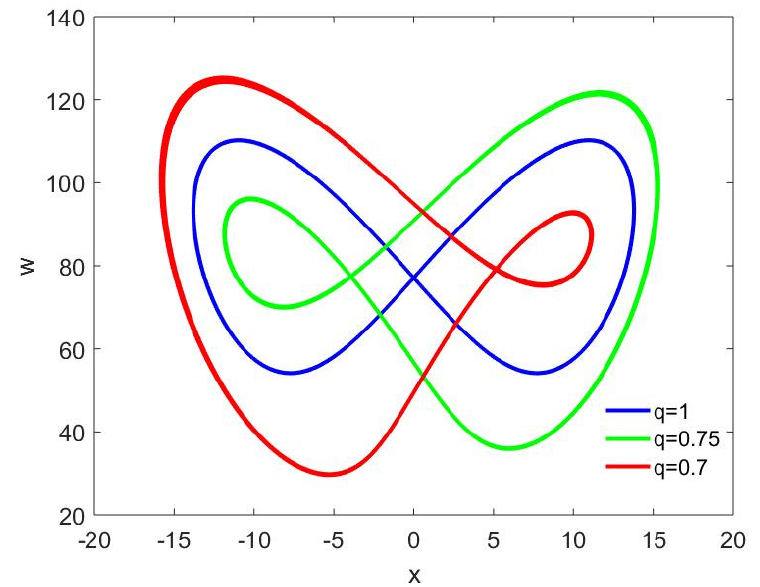
Figure 6. Phase portrait projected onto the x − w phase plane of system (11) with the order q = 1, q = 0.75, and q = 0.7 when d = 3.5.